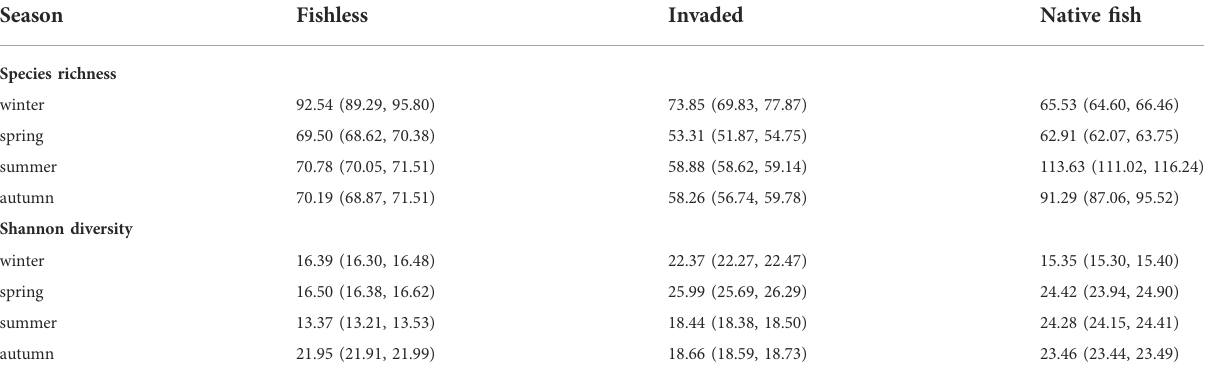
TABLE 4 Asymptotes of Lomolino models fi tted to species accumulation and Tsallis ’ s diversity accumulation curves, represent estimated species richness and Shannon diversity, respectively, under condition of complete sampling. Values in brackets indicate the 95% con fi dence interval.